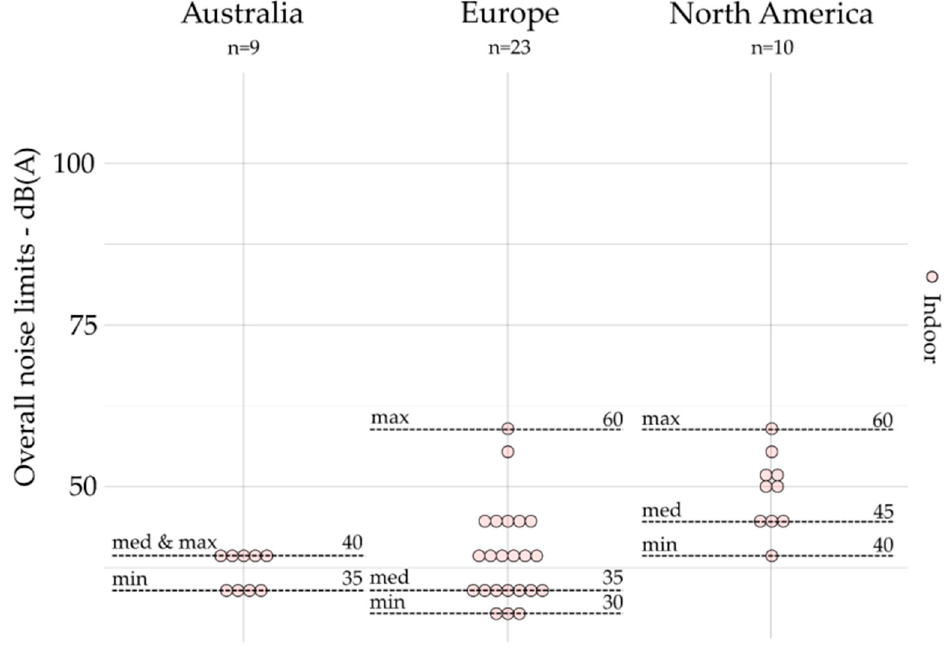
Figure 3. Overall indicators for indoors (all zones combined) grouped by geographic area ( n = 42).